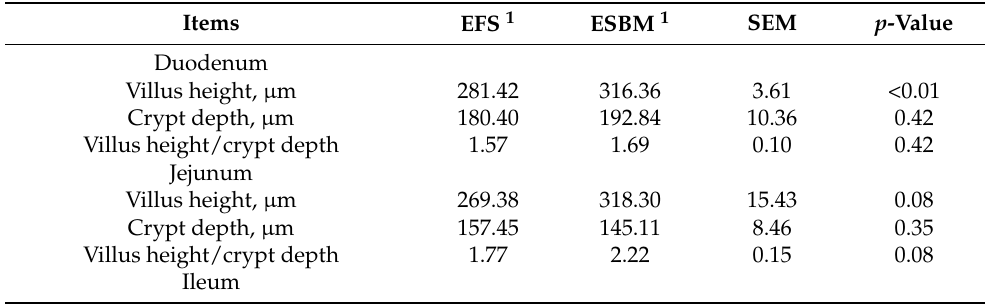
Table 6. Effects of enzyme-treated soybean meal replacing extruded full-fat soybean on intestinal morphology in nursery